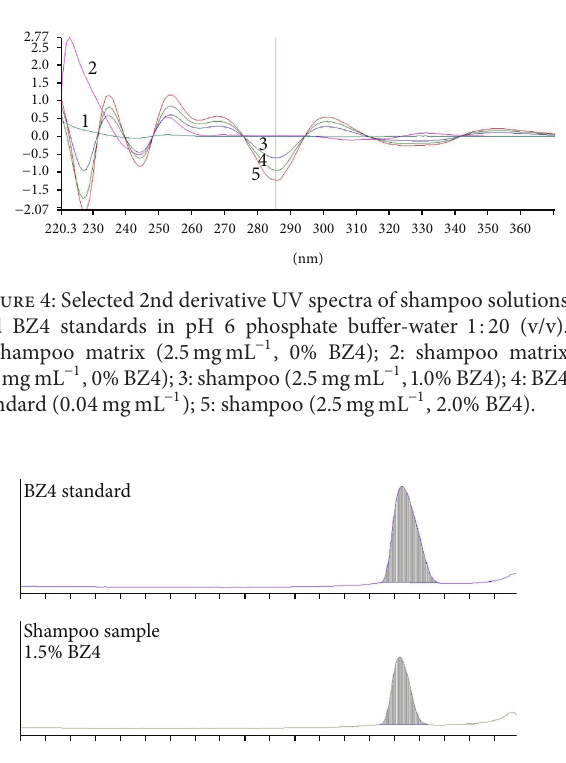
Figure 5: Densitogram of BZ4 standard (1.8 𝜇 g) and shampoo sample (1.5% BZ4).